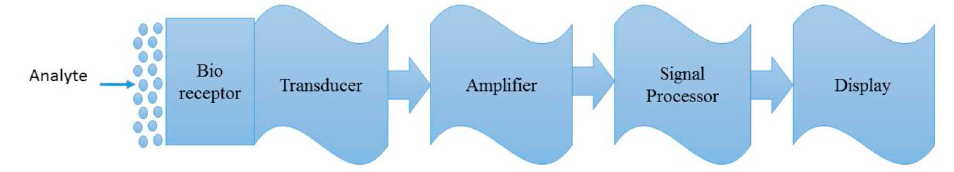
Figure 1. Schematic diagram of a biosensor.